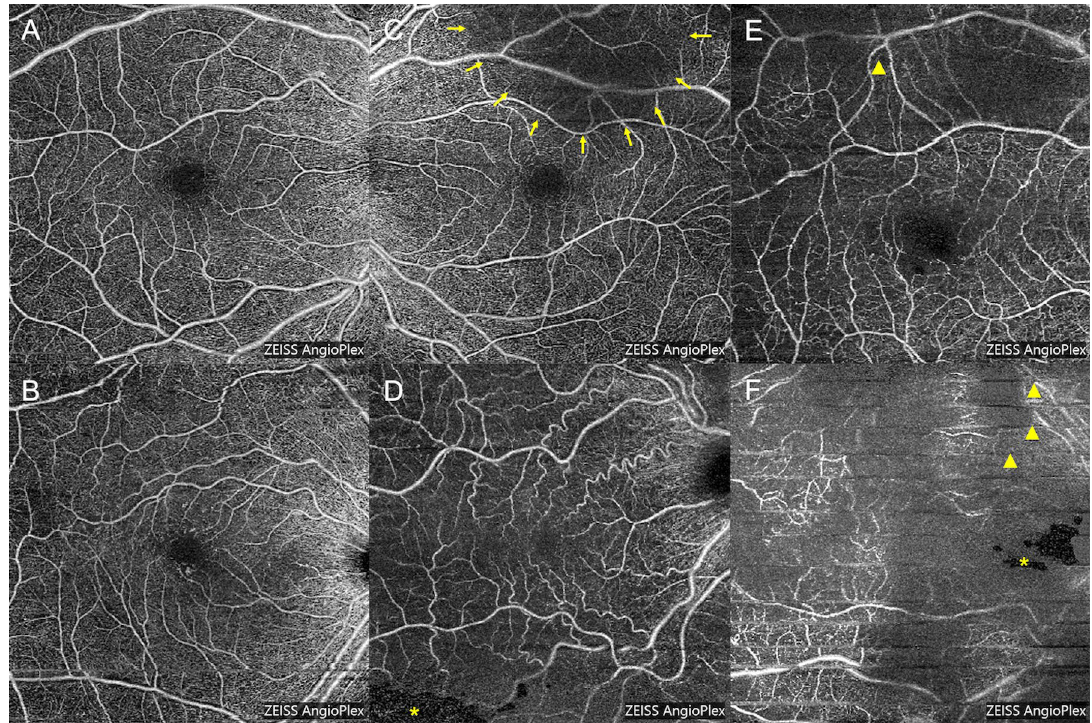
Figure 1. Representative examples of 8 × 8 mm OCTA images of the superficial capillary plexus with gradability score of 2 ( A,B ), 1 ( C,D ), and 0 ( E,F ). Image artifacts displayed include blink lines (arrowheads), segmentation artifact (asterisks), and media opacity (arrows). Image ( E ) is also